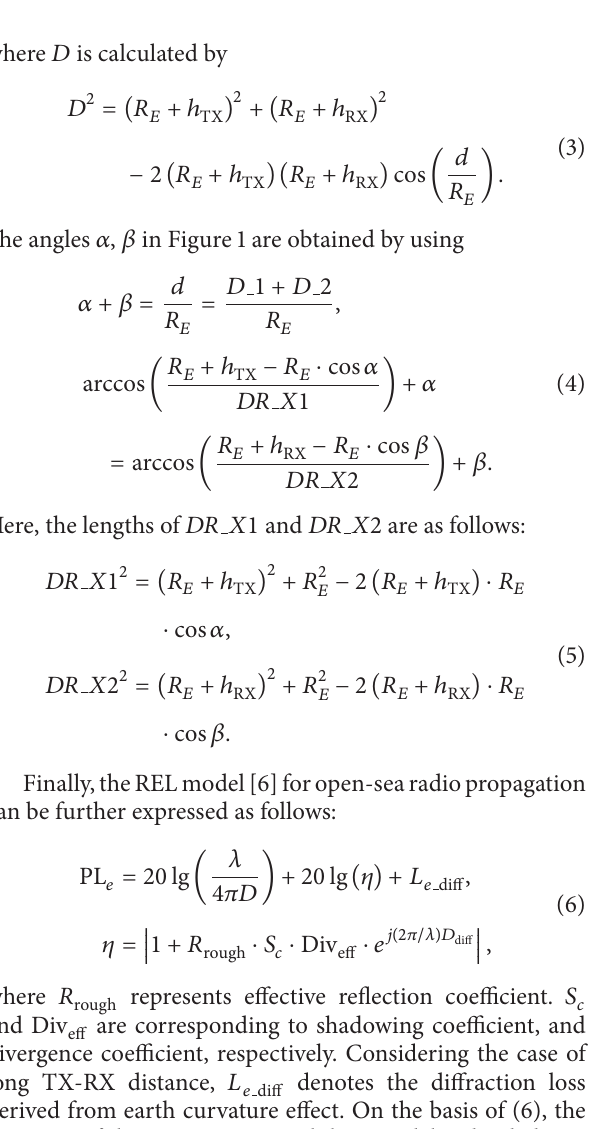
Figure 2: The structure of REL